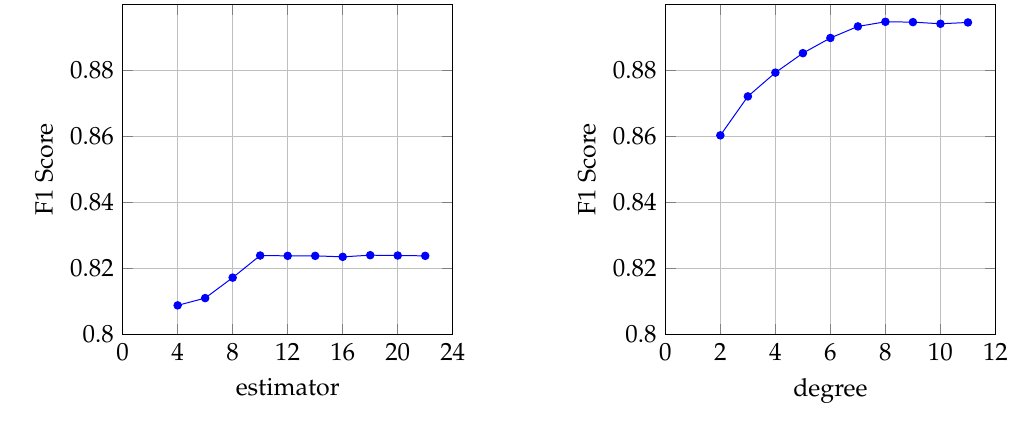
Figure 4. Hyperparameter selection A.